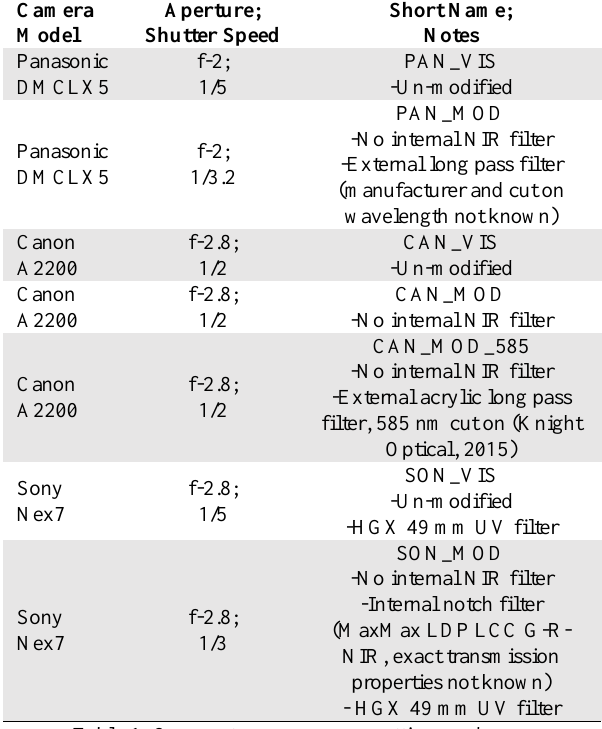
Table 1: Camera types, exposure settings and modifications. Each camera used an ISO of 100 throughout the experiment.